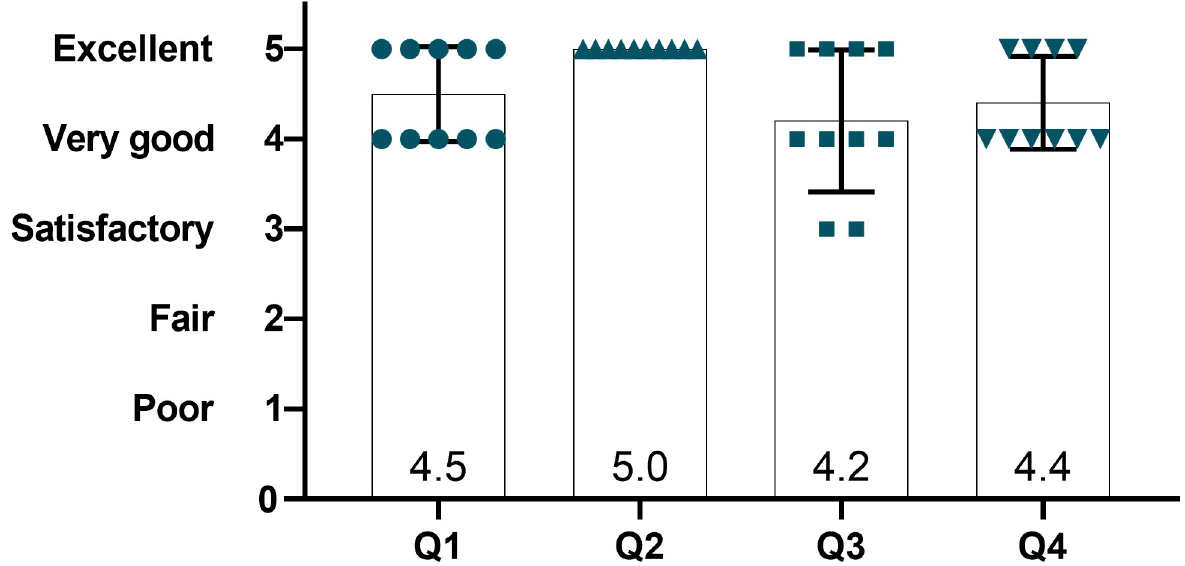
Fig 4. Surgeons assessment of model fidelity. Q1: Rate anatomical accuracy. Q2: Rate model size accuracy. Q3: Rate Landmarks visibility. Q4: Rate tactile fidelity during surgery (Haptic feedback). Data presented with mean and SD.